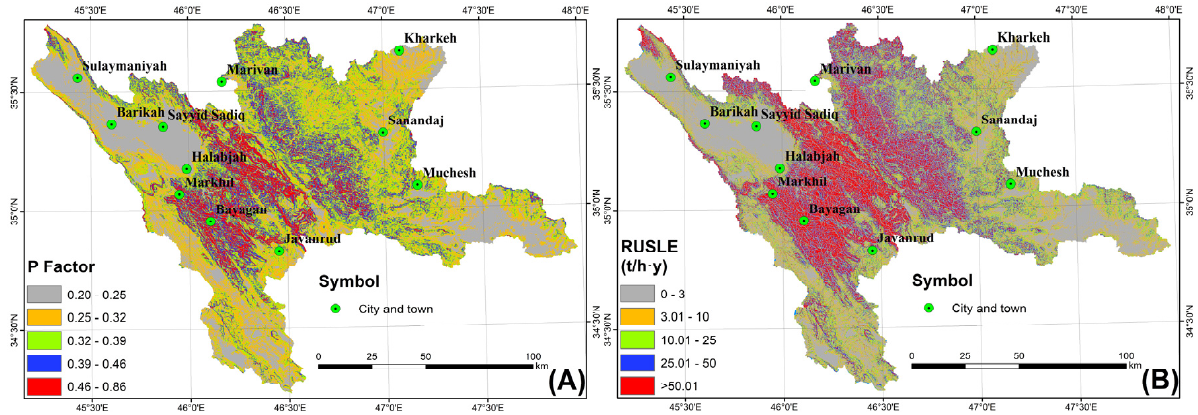
Figure 9. The distribution of the ( A ) P factors and ( B ) RUSLE maps within the DLB for the period until 2 May 2008.